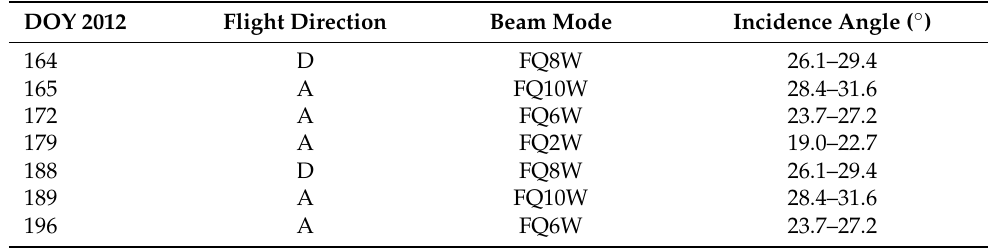
Table 5. Characteristics of Wide mode Quad-pol RADARSAT-2 data. The ascending (A) and descend- ing (D) directions correspond to the 7:10 PM and the 7:50 AM overpasses,